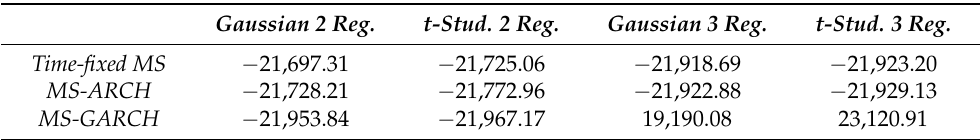
Table 3. Mean DIC observed value for the simulated portfolios. Gaussian 2 Reg. t-Stud. 2